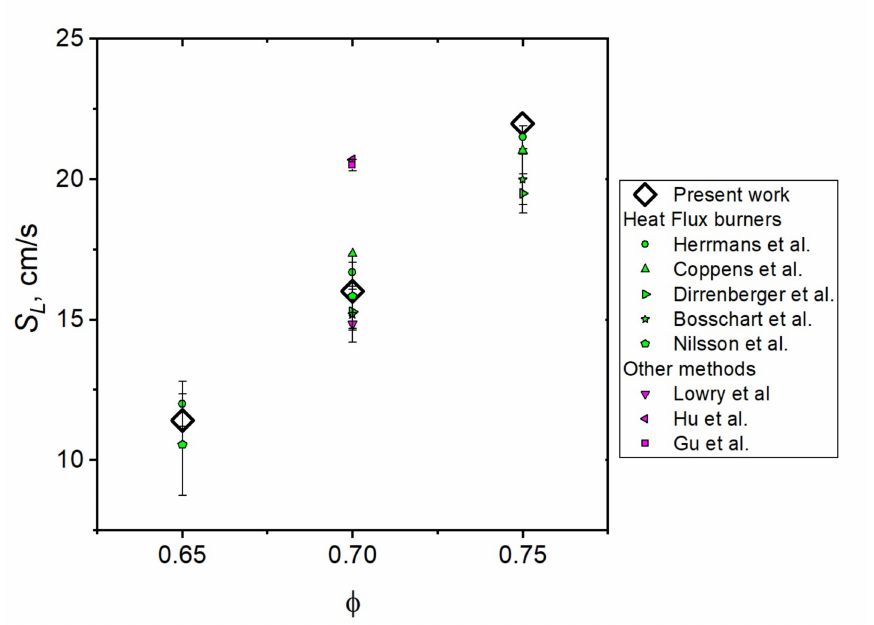
Figure 5. Laminar burning velocities at lean conditions for standard conditions methane/air flame, results from present study (open diamonds) and recent literature [28–35].